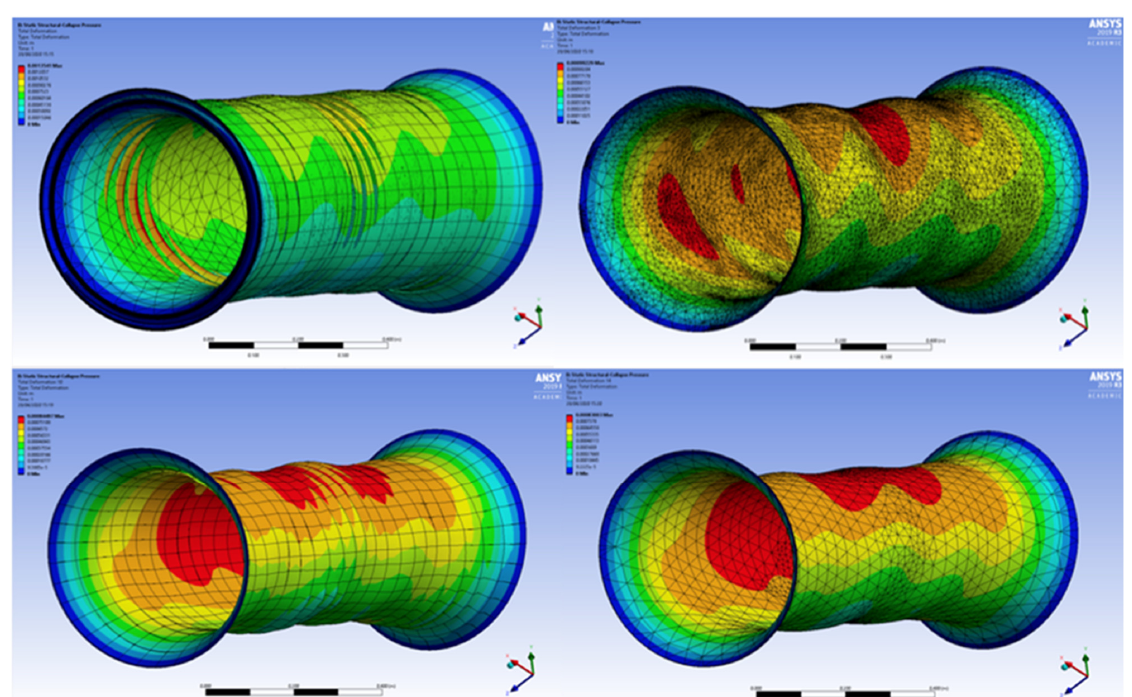
Figure 18. Collapse loading of different layers under extreme conditions, for total deformation on 4 different layers of the marine hose (under 0.5 × magnification, and the ends are without end fitting or additional reinforced